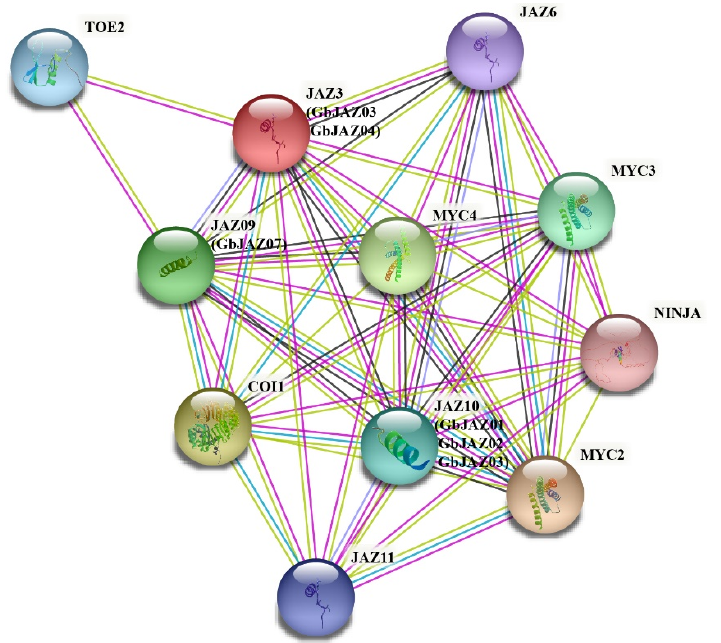
Figure 7. The functional regulatory network of G. biloba JAZ proteins. The protein–protein interaction of JAZ proteins was predicted using STRING software. The cyan line represents data from curated databases; the purple line experimentally determined data; the green line gene neighborhood; the blue line gene co-occurrence; the yellow line text mining; the black line co-expression; and the gray line protein homology.